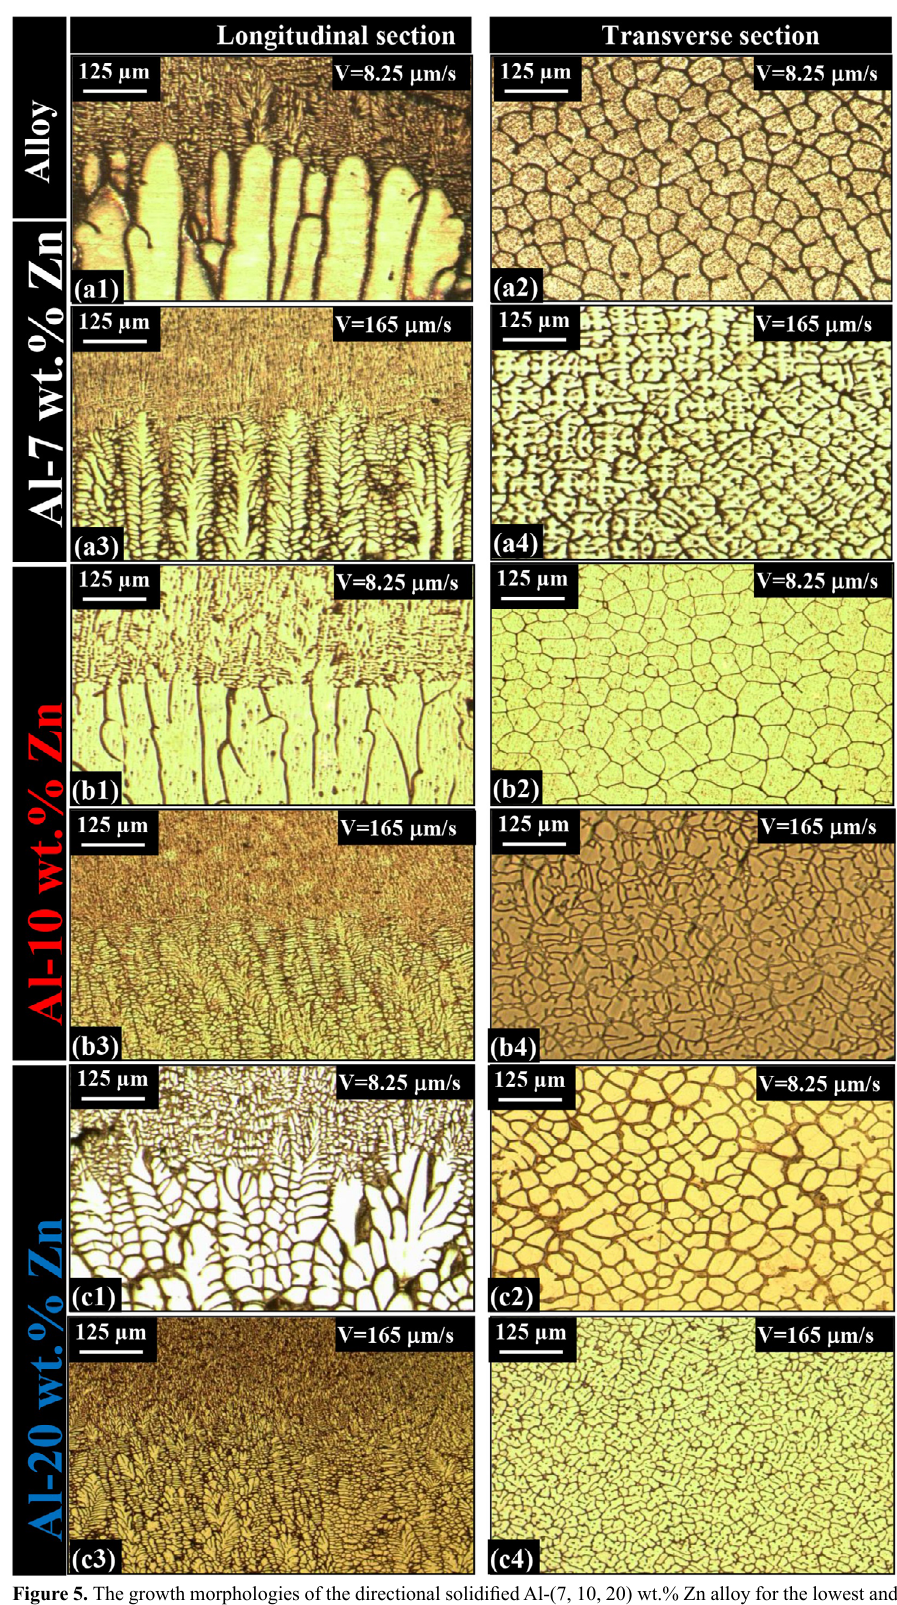
Figure 5. The growth morphologies of the directional solidified Al-(7, 10, 20) wt.% Zn alloy for the lowest and the highest growth velocities (a1-a4) Al-7 wt.% Zn, (b1-b4) Al-10 wt.% Zn, (c1-c4) Al-20 wt.%